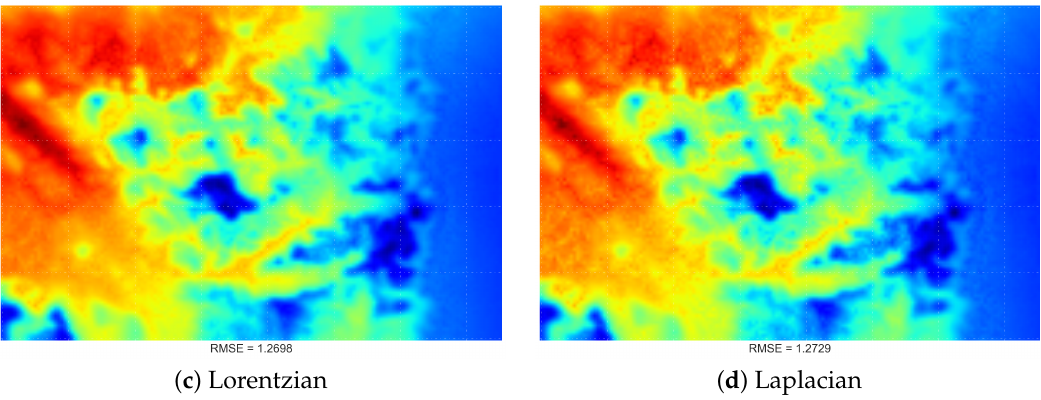
Figure 13. Visualisation output of IDW ( a ) and the proposed DDW: ( b ) Gaussian; ( c ) Lorentzian; and ( d ) Laplacian; using the proposed spatiotemporal interpolation technique.